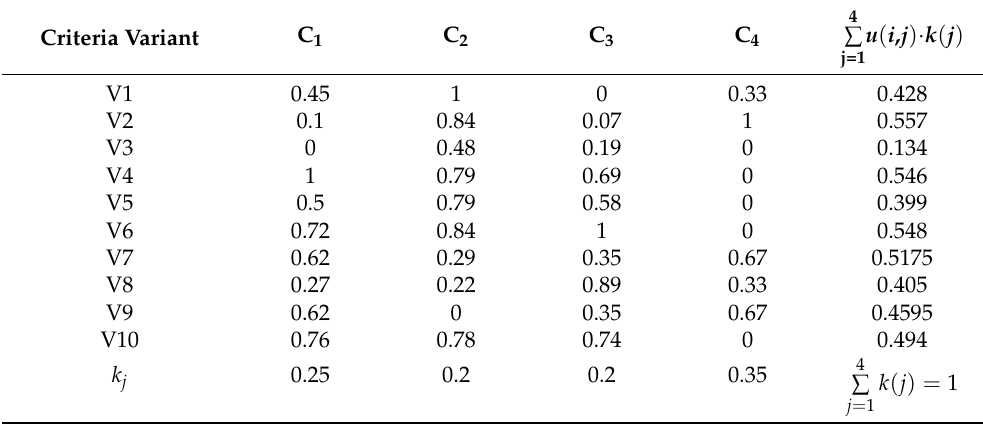
Table 8. Utility and decision matrix when the training cell can be configured for complete assembly of the electric motor by an